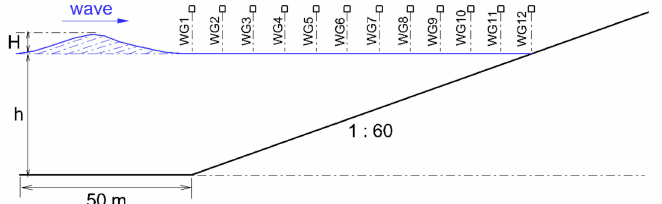
Figure 3. Computational layout for solitary wave runup on a plane beach.